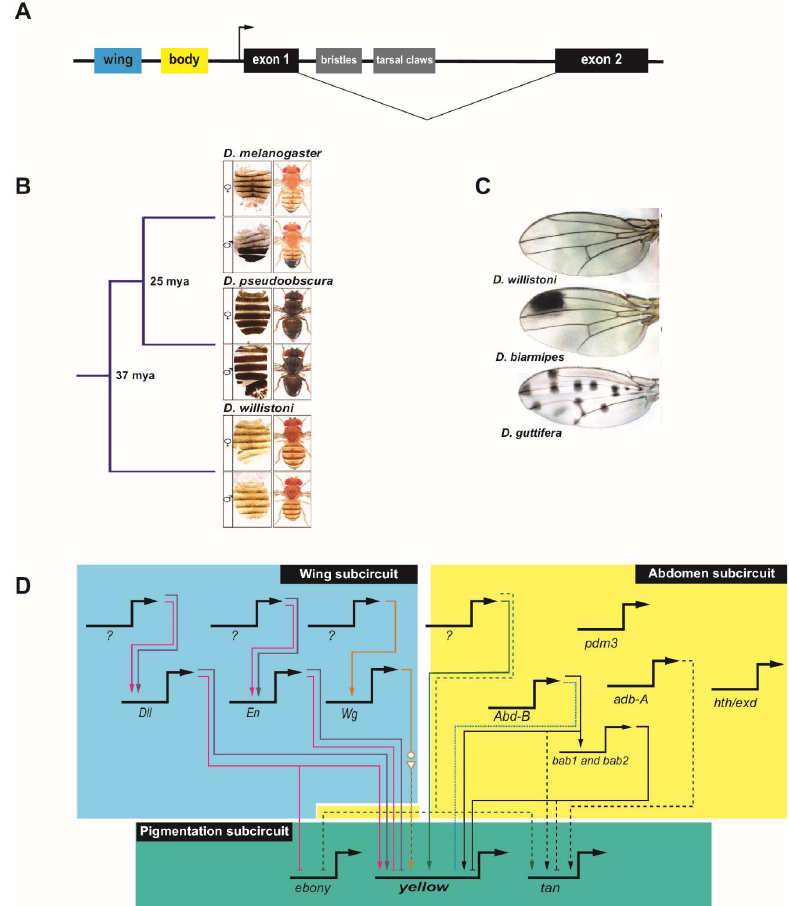
Figure 2. The Drosophila pigmentation gene regulatory network subcircuit. ( A ) Schematic of the yellow locus, with the positions of the ‘body element’ and ‘wing enhancer” highlighted. The bristle and tarsal claw CRMs are shown in grey. Note that additional regulatory sequences, not pictured, can be found throughout the locus, including in the large intron (drawing not to scale). ( B ) The differences in abdominal pigmentation and the phylogenetic relationship between three species, (top to bottom) D. melanogaster , D. pseudoobscura , and D. willistoni . From left to right: dissected dorsal abdomen and dorsal view of adult fly for males and females. ( C ) Wings from D. willistoni , D. biarmipes , and D. guttifera , showing differences in pigmentation pattern. ( D ) Partial schematic of the Drosophila pigmentation GRN, with emphasis on yellow ; see text for details. The regulation of yellow , ebony , and tan by upstream factors is either direct (solid lines) or indirect (dashed lines) and can be in the form of activating (arrow) or repressive (bar) inputs. Species-specific loss of binding is shown using a dotted line. Unknown upstream factors are denoted by question marks. The wing (blue box) and abdomen (yellow box) subcircuits are shown separately, even though they share components, to better illustrate the regulatory differences in these tissues. The abdomen subcircuit focuses on regulation in the A5 and A6 segments. Multiple species have been incorporated into one network; however, the individual CRMs involved are not depicted. Although additional linkages can be inferred, for simplicity only those discussed in the text are included. Linkages unique to D. melanogaster are colored black, those specific to D. prostipennis are colored green, those specific to D. kikkawai are colored blue, those specific to D. biampries are colored pink, those specific to D. elegans are colored purple, and those specific to D. guttifera are colored orange. Image credits: panel B, © Kalay, et al. [19] used with permission under CC-BY 4.0 license; panel C, reprinted from Rebeiz and Williams [13], © Elsevier, used with